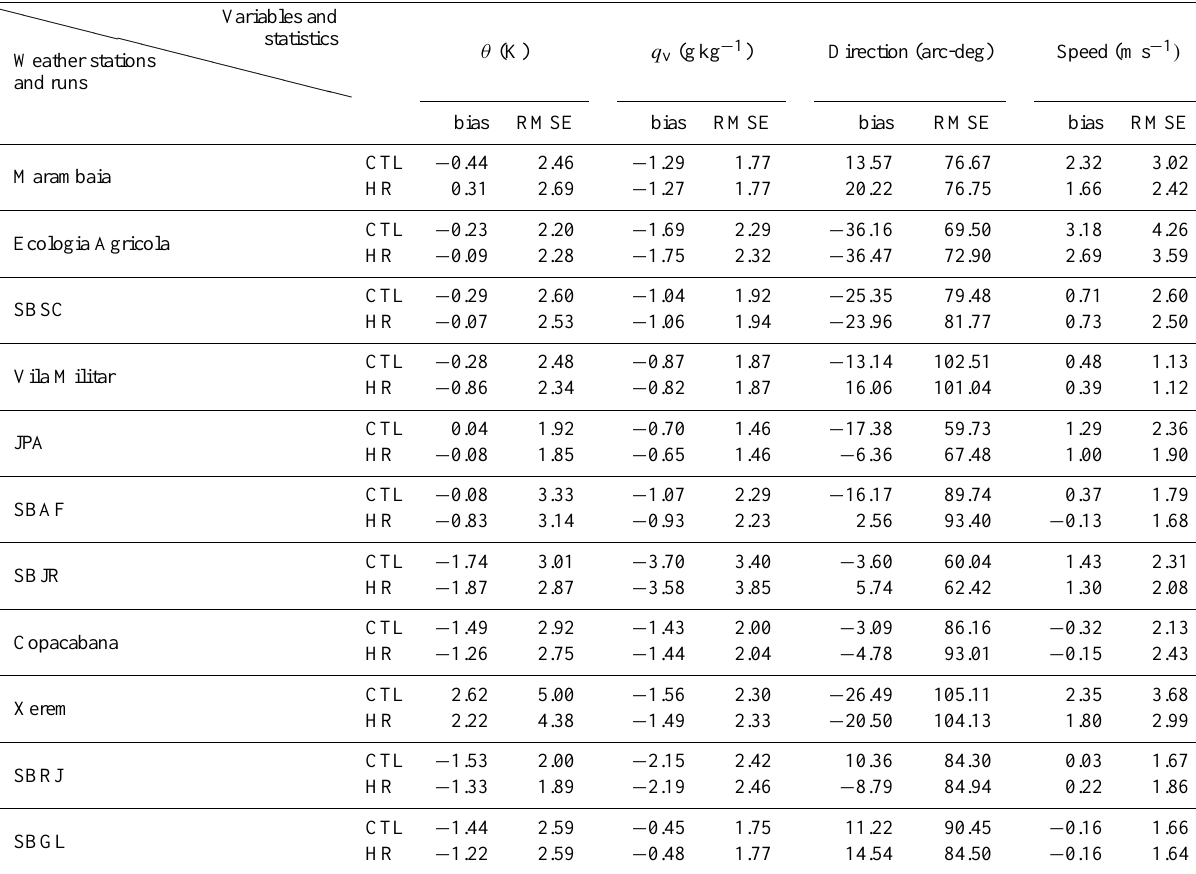
Table 5. Mean errors (bias) and RMSEs for θ , q v , wind direction and speed.